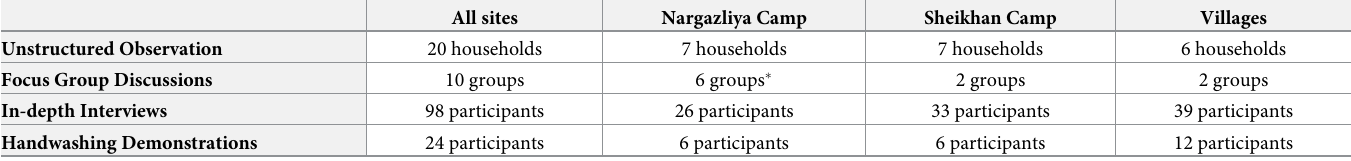
Table 2. Summary of the number of participants per